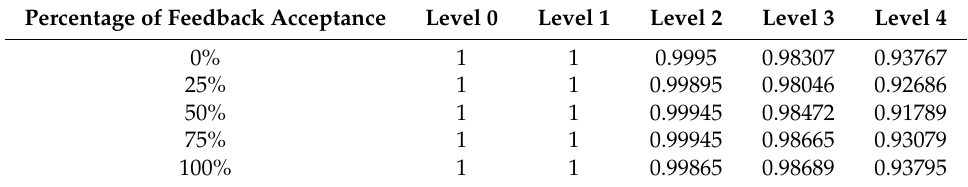
Table 5. User trust levels concerning autonomy when the devices’ error increases with the task level and the user is